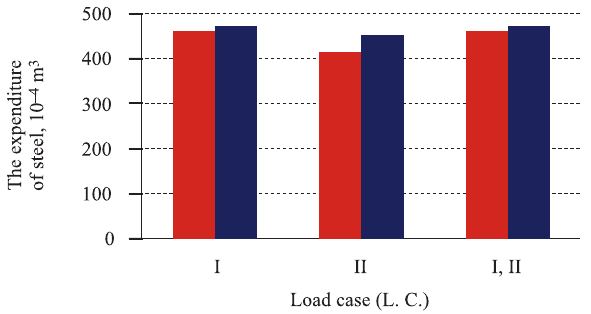
Fig. 8. The expenditure of steel, when h = 1.50 m: – Matlab; – autodesk robot structural analysis